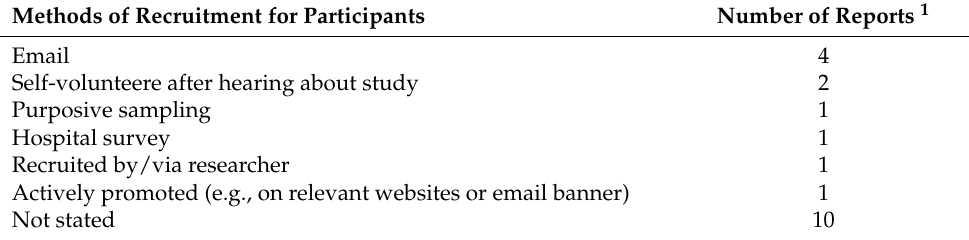
Table 1. Methods of recruitment for VCoP participants.